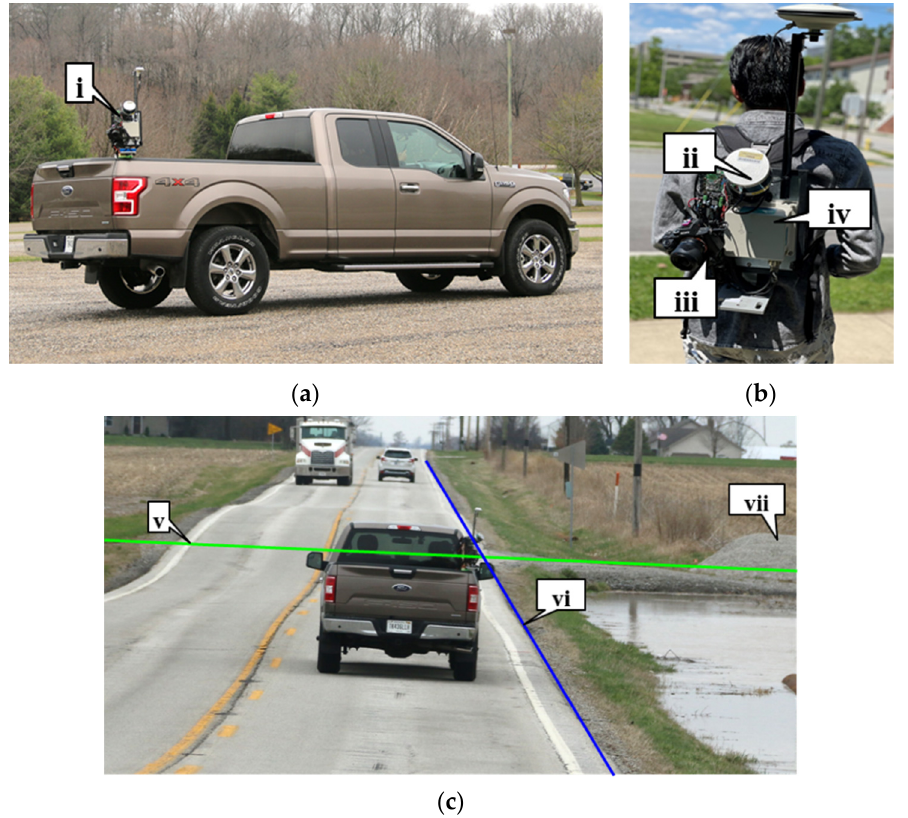
Figure 16. Pilot mobile mapping system for agency deployment: ( a ) pilot mobile mapping system; ( b ) components of pilot mobile mapping system; ( c ) utilization of single sensor pilot mobile mapping system.